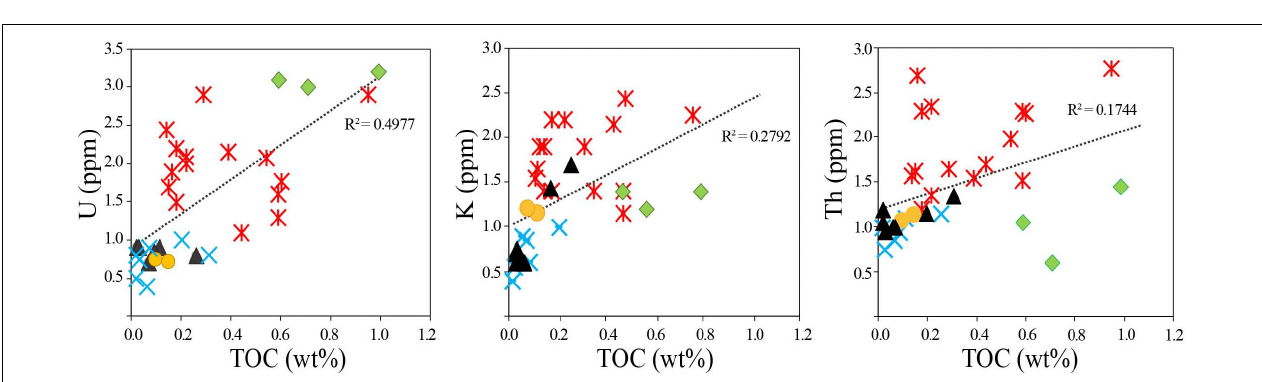
FIGURE 10 | Plotting of U, K, and Th concentrations and TOC in five sedimentary facies provides a scattering pattern of data